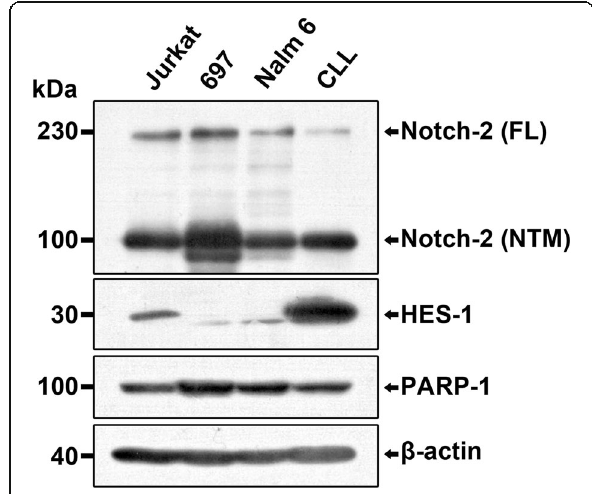
Fig. 5 Western blot analysis of Notch signalling molecules in leukaemia cell lines. Whole-cell extracts were subjected to immunoblot analysis and incubated with antibodies binding to Notch2, Hes1, PARP1 and β -actin as a loading control. Cell